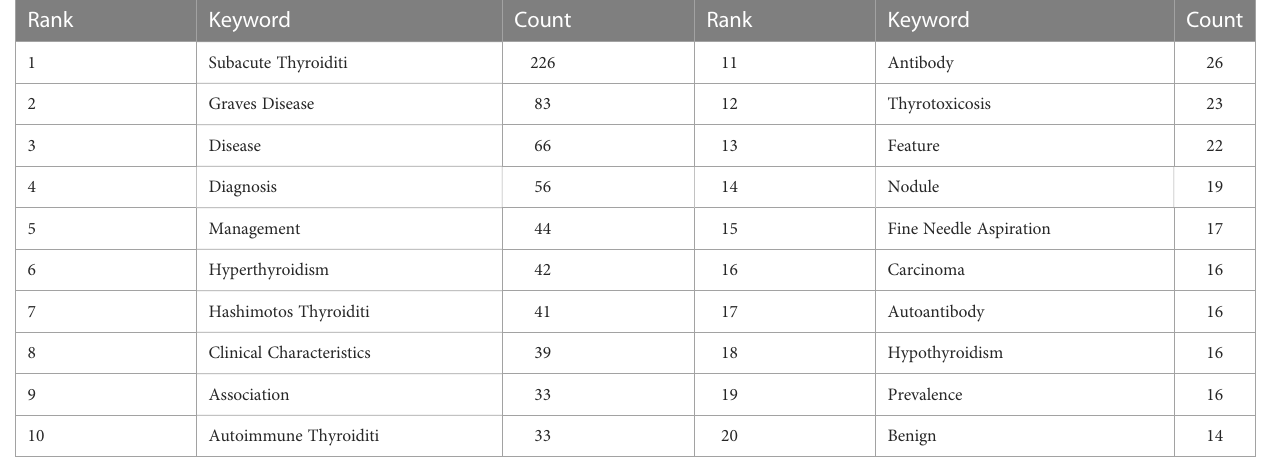
TABLE 4 The top 20 keywords associated with SAT